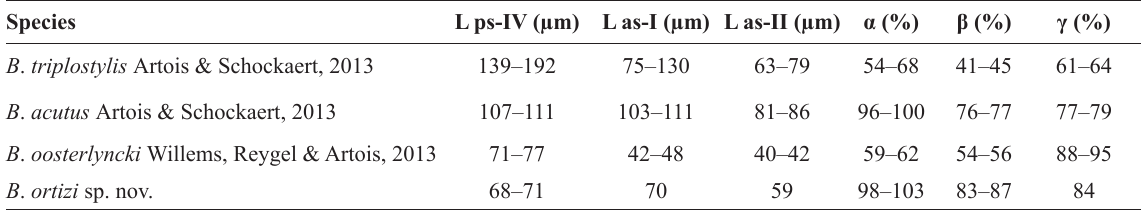
Table 1. Comparison of the lengths and proportions between the stylets of species of Brachyrhynchoides Artois & Schockaert, 2013. Abbreviations: L = length; ps-IV = prostatic stylet type IV; as-I =